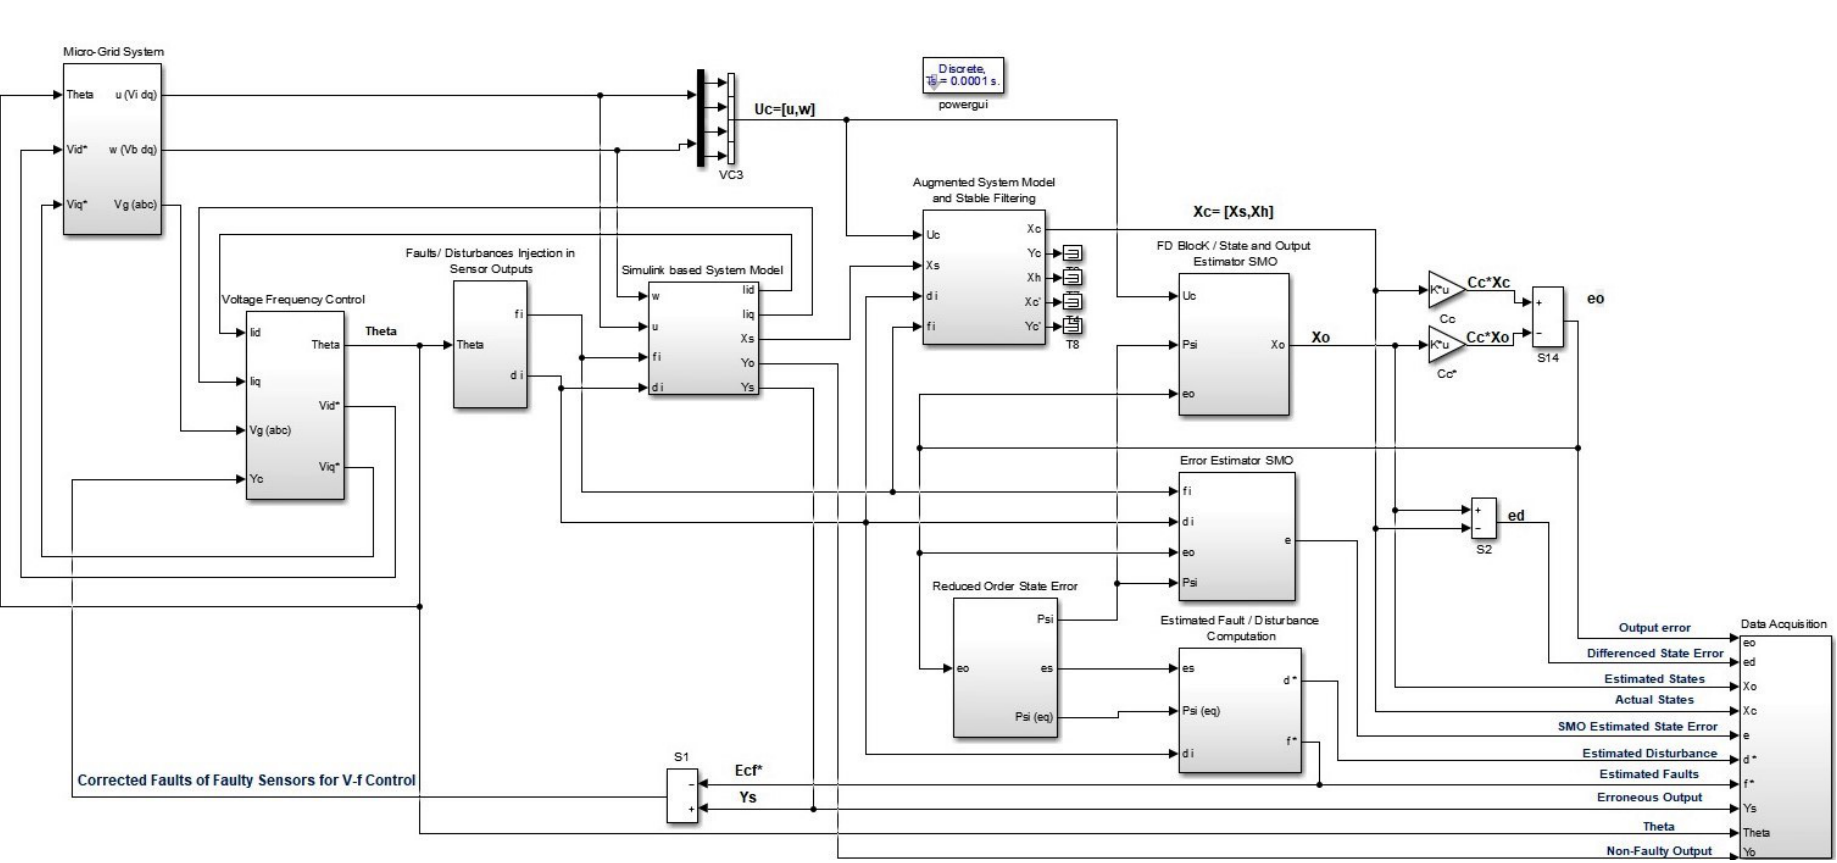
Figure 3. Simulink-based detailed block diagram of the used